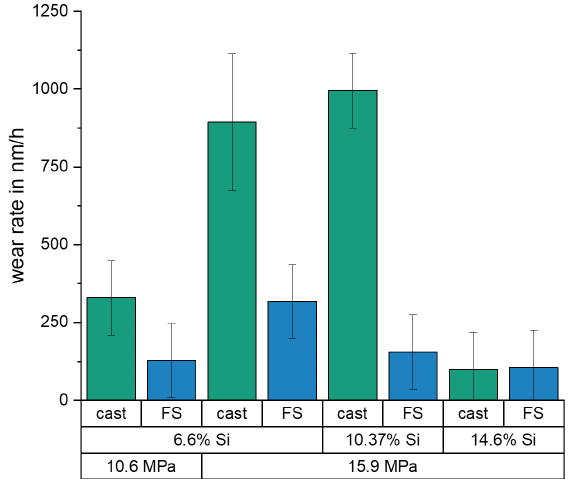
Figure 7. Wear rates (weight loss) at end of tests with different contact pressures (10.6MPa and 15.9MPa), for the three alloys (6.6%, 10.4% and 14.6% Si) in FS and as-cast